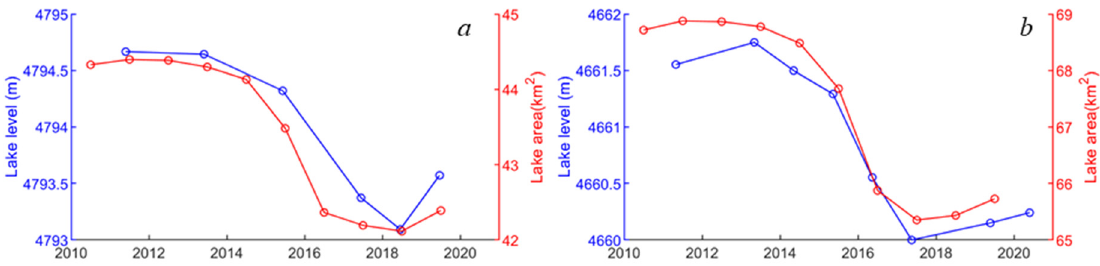
Figure 6. Comparison of lake area and water level changes of Puga Co ( a ) and Ringco Ogma ( b ) in 2010–2020.